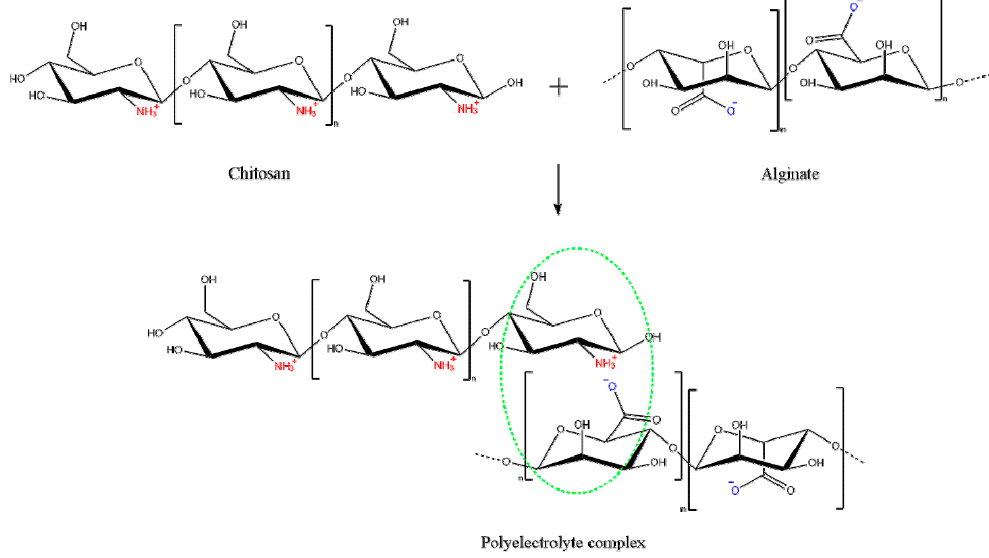
Figure 9. Schematic representation of the interaction between alginate as a polyanion and chitosan as polycation: mixing of the oppositely charged polyelectrolytes leads to formation of a polyelectrolyte complex caused by the electrostatic interactions between the ions.